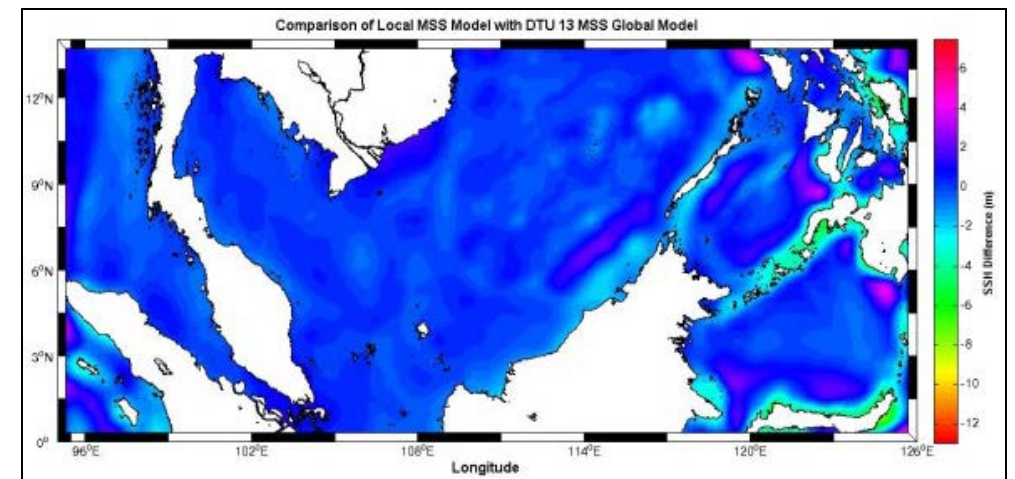
Figure 11. Difference between the DTU13 Global MSS Model and Localised MSS Model in Malaysian Seas displayed on a 0.25° resolution